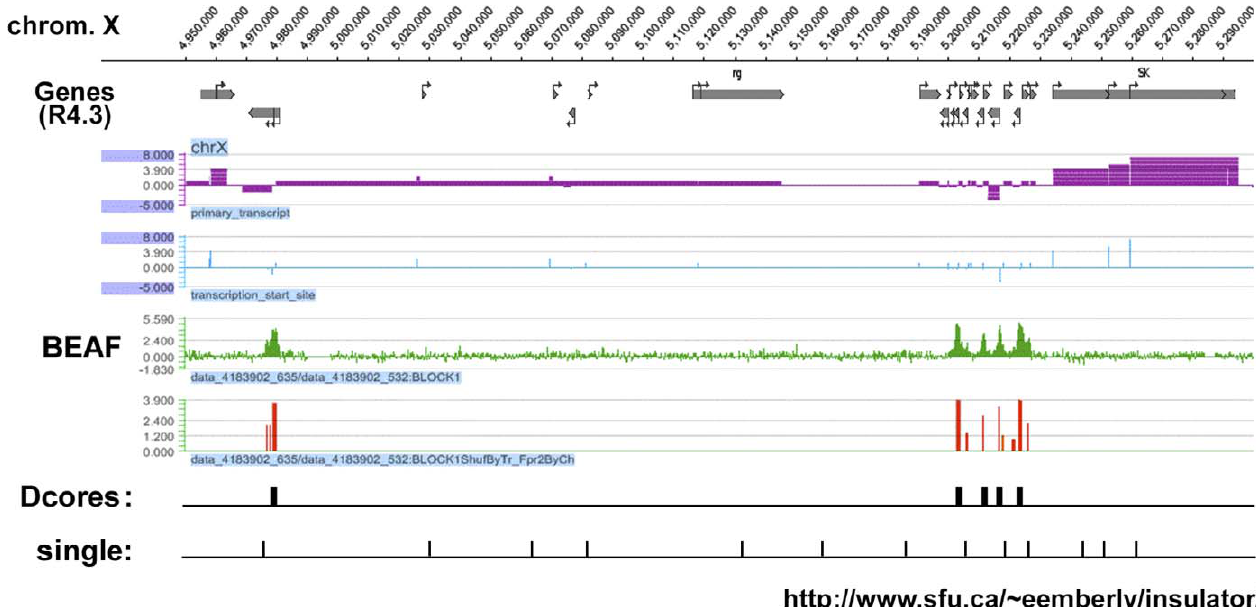
Figure 2. ChIP-on Chip Analysis Shows That BEAF Peaks Corresponding to Dual-Cores The panel shows an alignment of ChIP-on-chip analysis using anti-BEAF antibodies (see the graph in green with red bars marking the position of significant peaks), with our dual-core database (Dcores, black rectangles) (http://www.sfu.ca/ ; eemberly/insulator/), over a region of the X chromosome (nucleotide positions 4,950,000 to 5,300,000). Single elements not forming dual-cores are also shown (single:, black bars). Note that all five peaks fit into dual-cores. The second peak from the left is X-Dcore38_D, which juxtaposes the cdk7 gene. Transcription start sites (blue bars) and primary transcripts (purple lines) are shown on top.